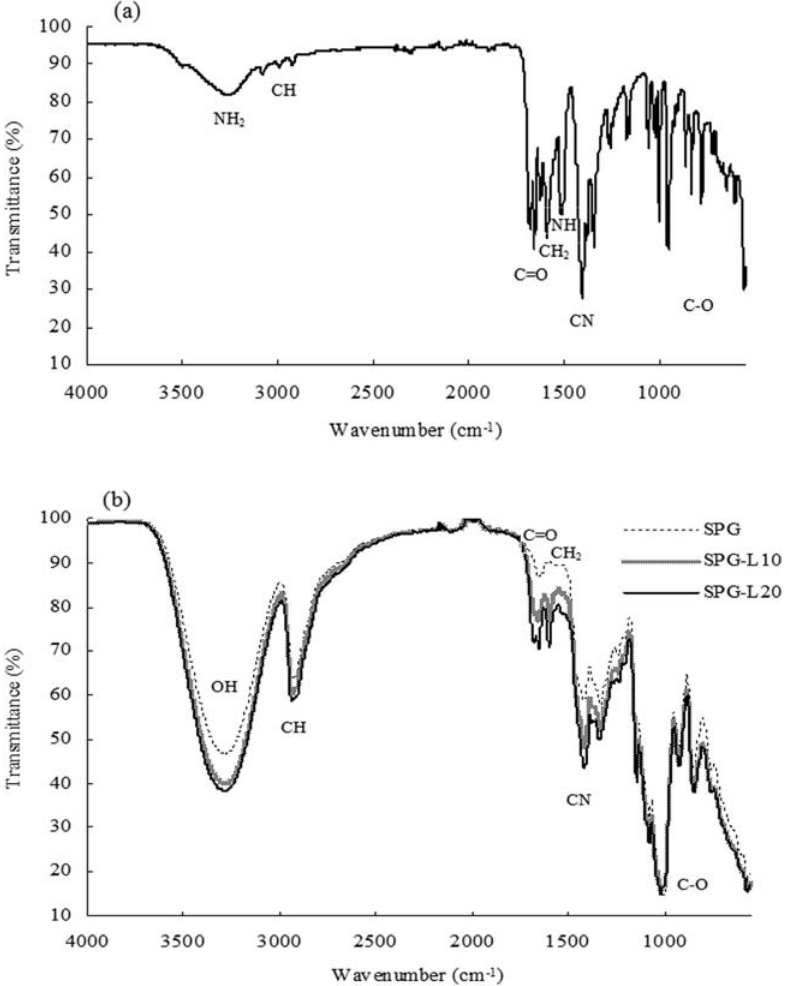
Figure 1: FTIR spectroscopy of ε - polylysine ( a ) and starch/PVA/glycerol composite fi lms without and with 10% and 20 wt% of ε - polylysine ( b )